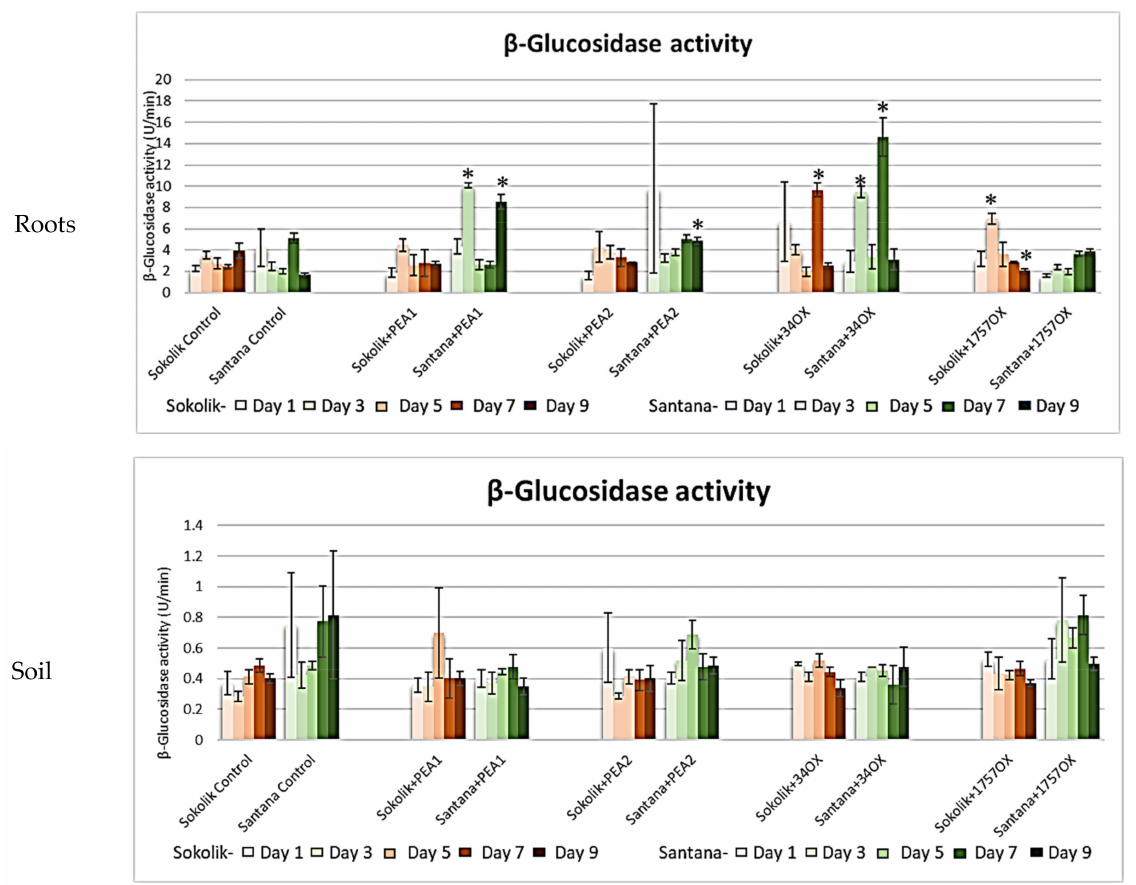
Figure 5. β − glucosidase activity (micrograms of P-nitrophenol produced per minute (U/min)) obtained from the roots and soil of Sokolik and Santana infected with PEA1, PEA2, 34OX and 1757OX and the control (calculated from triplicate treatments). Error bar represents the standard error. * Statistically significant ( p <